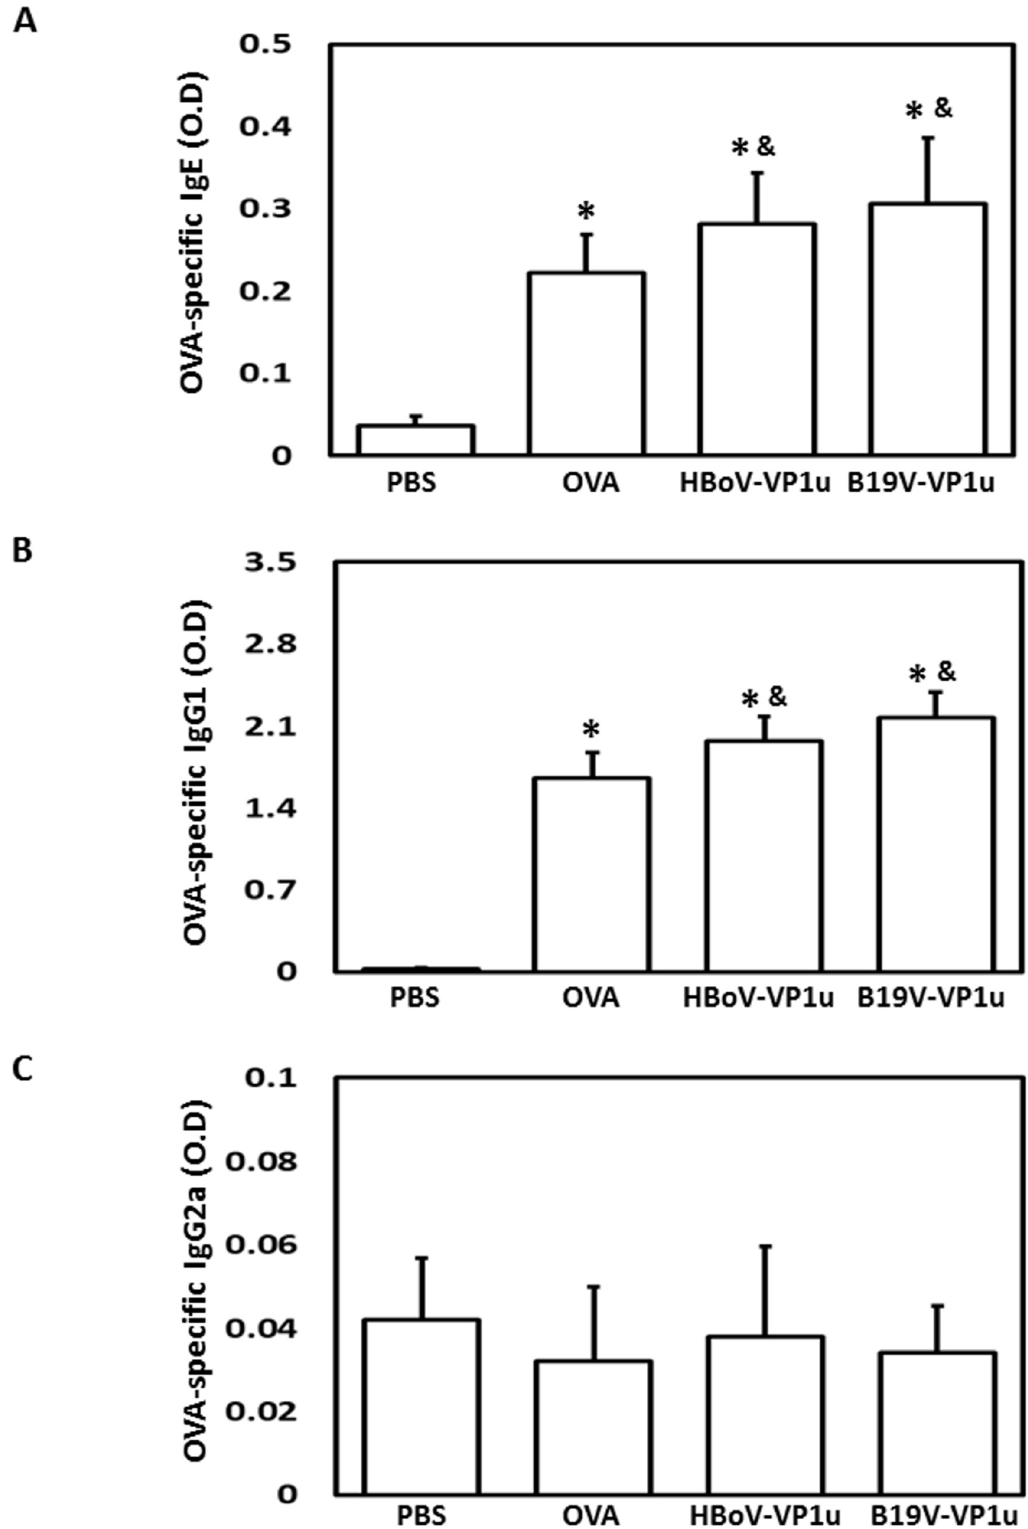
Fig 4. OVA-specific antibodies in BALF. The levels of OVA-specific (A) IgE, (B) IgG1 and (C) IgG2a in BALF were detected in mice from PBS, OVA, HBoV-VP1u and B19V-VP1u groups. Values are mean ± SD. Similar results were observed in three